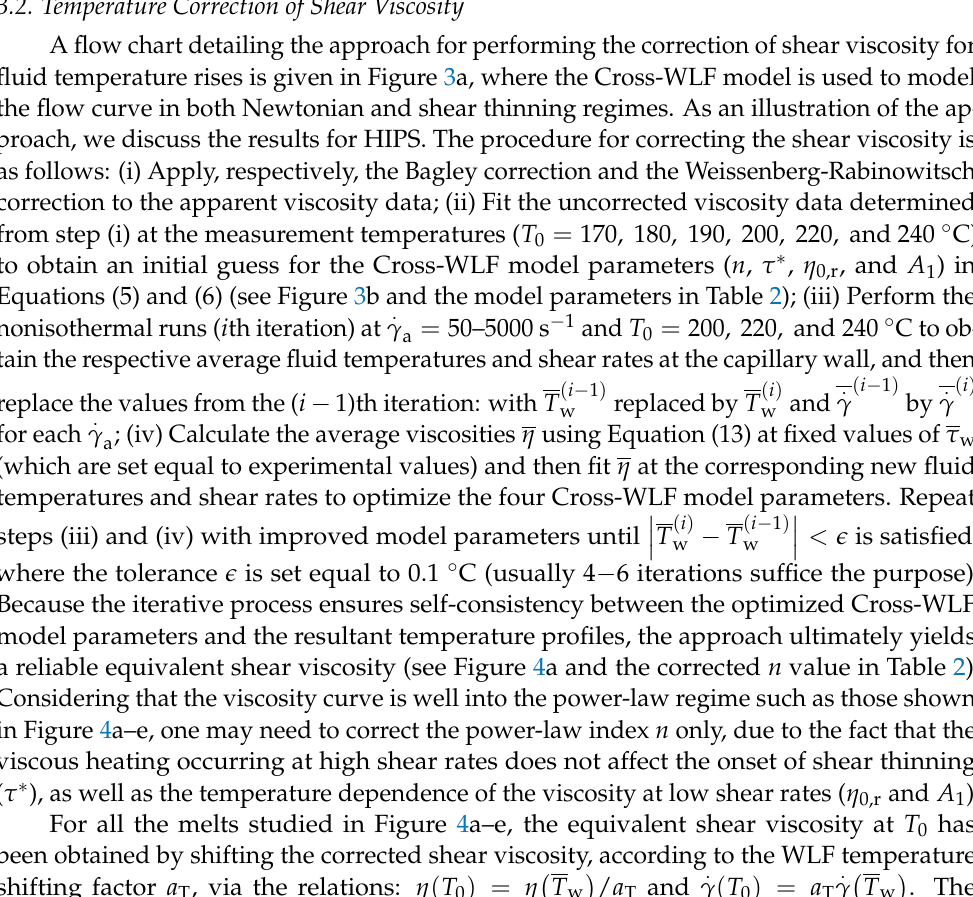
Figure 3. ( a ) Flow chart illustrating the viscous heating correction of the shear viscosity η ( . γ ) for shear viscosity η (